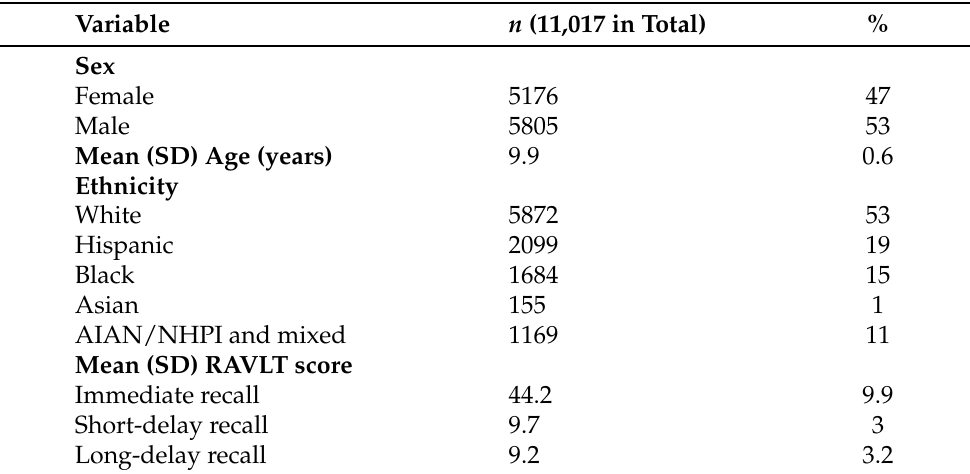
Table 1. Demographic and cognitive characteristics of the Adolescent Brain Cognitive Develop- ment sample.